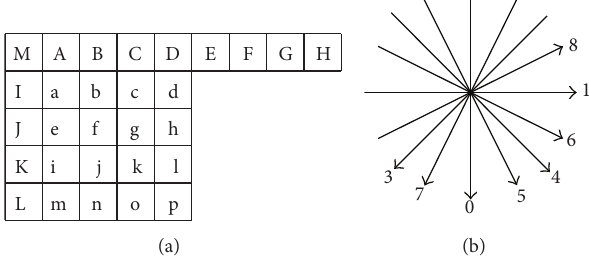
Figure 1: The 4 × 4 luma block and prediction directions. (a) For a 4 × 4 luma block, a to p are the pixels to be predicted, and A to M are the neighboring pixels that are available of prediction. (b) Eight prediction directions for intraprediction of 4 × 4 luma